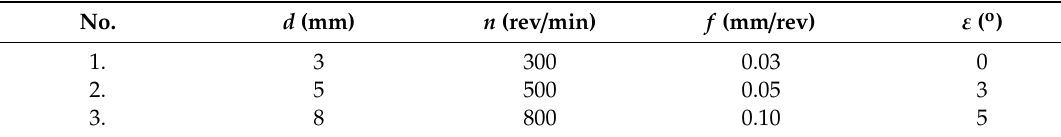
Table 1. The experiment’s factor